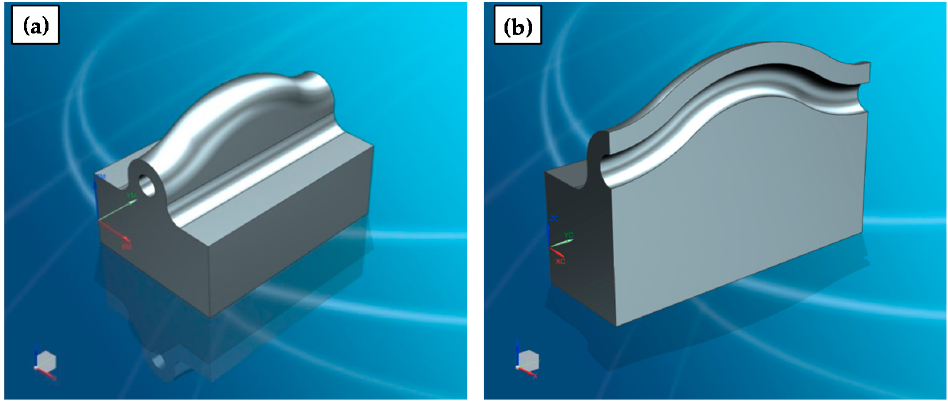
Figure 13. ( a ) Isometric view; ( b ) cross section of the 3D conformal cooling CAD model.